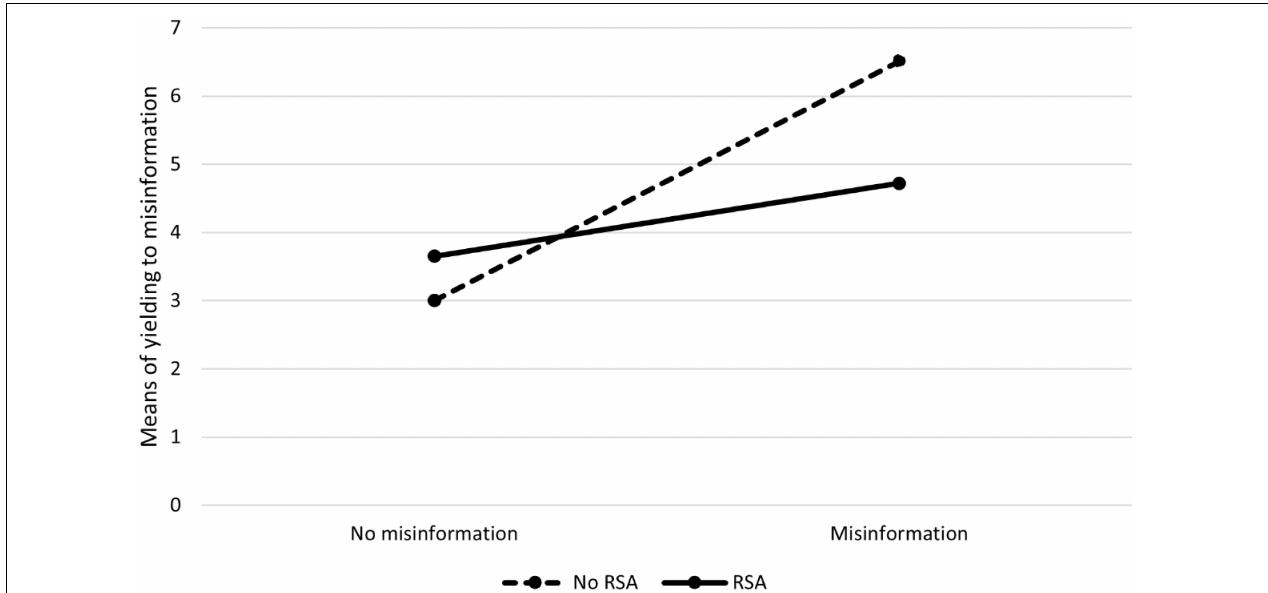
FIGURE 2 | Means of yielding to misinformation across experimental conditions in Experiment